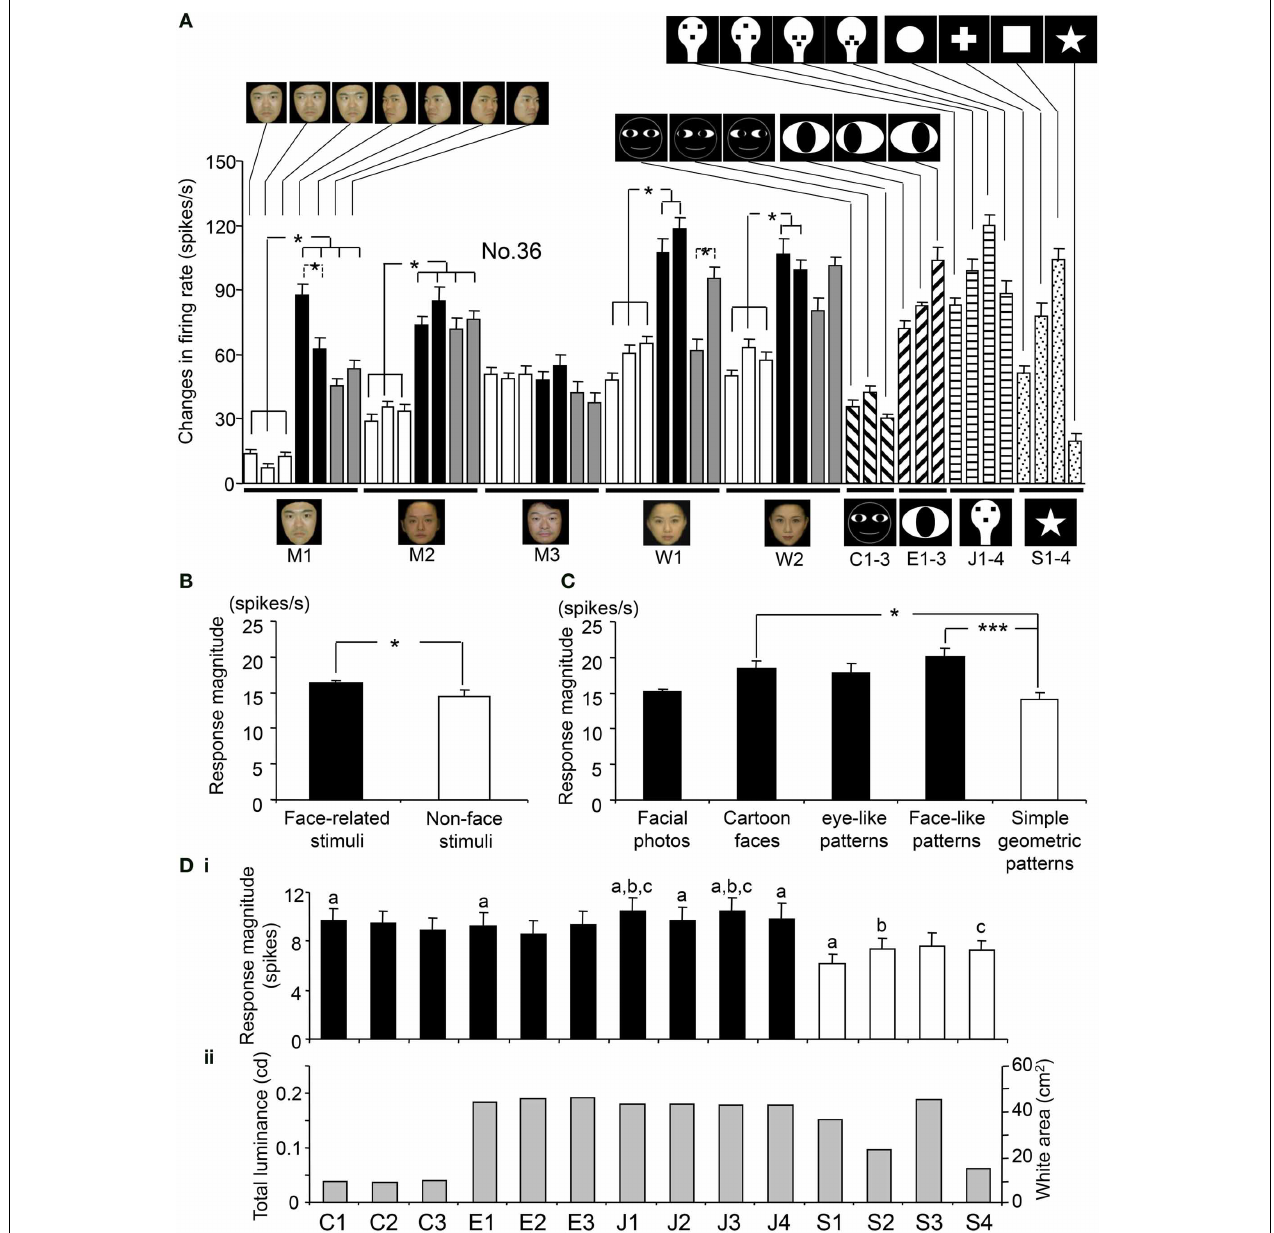
FIGURE 5 | Response magnitudes during stimulus presentation (500ms) to the visual stimuli. (A) Comparison of the response magnitudes to all of the visual stimuli during stimulus presentation (500ms) for the neuron shown in Figure 4 . All of the 49 stimuli elicited significant excitatory responses [Wilcoxon signed-rank (WSR), p < 0 . 05]. For each facial model, the response magnitudes to the profile faces were significantly greater than those to frontal faces (except model M3). The response magnitudes to the face-like patterns (J1-4) and the eye-like patterns (E1-3) were significantly greater than those to the cartoon faces (C1-3) (Tukey tests after One-Way ANOVA, p < 0 . 05). For each model, the responses to the stimuli with different head orientations and gaze directions are similarly aligned from the left, as for model M1. (B) Comparison of response magnitudes of the 112 visually responsive neurons to the face-related stimuli (facial photos, cartoon faces, eye-like patterns, and face-like patterns)